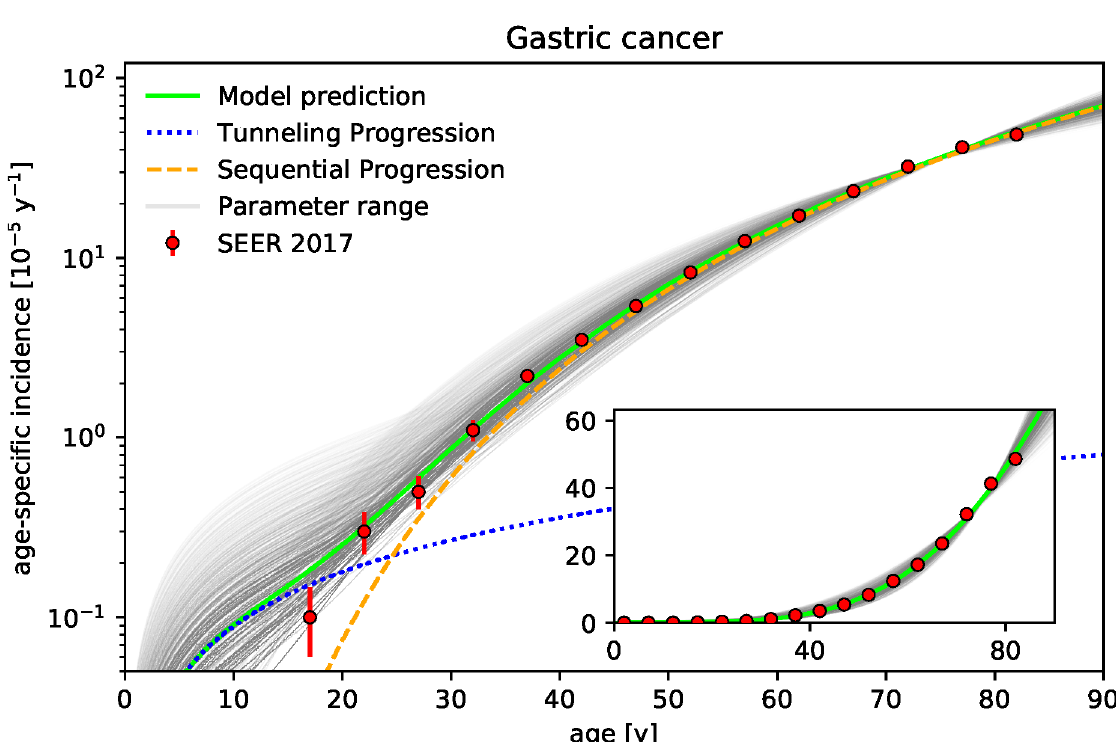
Fig 3. Niche competition could model age-specific incidence rates of gastric cancer. Age-specific incidence rates of gastric cancer predicted by the model show correspondence to epidemiological data (SEER database [33], displayed curves and points analogous to Fig 1). Since parameters are not available as detailed as for the colon, the range of the parameters N , u , v , and γ are assumed to match the ranges for the colon, see Table 1, while the range of the number of gastric glands K = 4–16 � 10 6 is estimated as described in the text. Exemplary parameter set with N = 7, K = 8 � 10 6 , u = 4.4 � 10 − 6 , v = 1.75 � 10 − 6 , and γ = 5% is highlighted in green. The effective replacement rate λ is found to be considerably smaller than replacement rates of colonic crypts ( λ = 0.014 y − 1 per stem cell for the green curve and λ = 0.02 ± 0.01 y − 1 for the gray curves illustrating the parameter